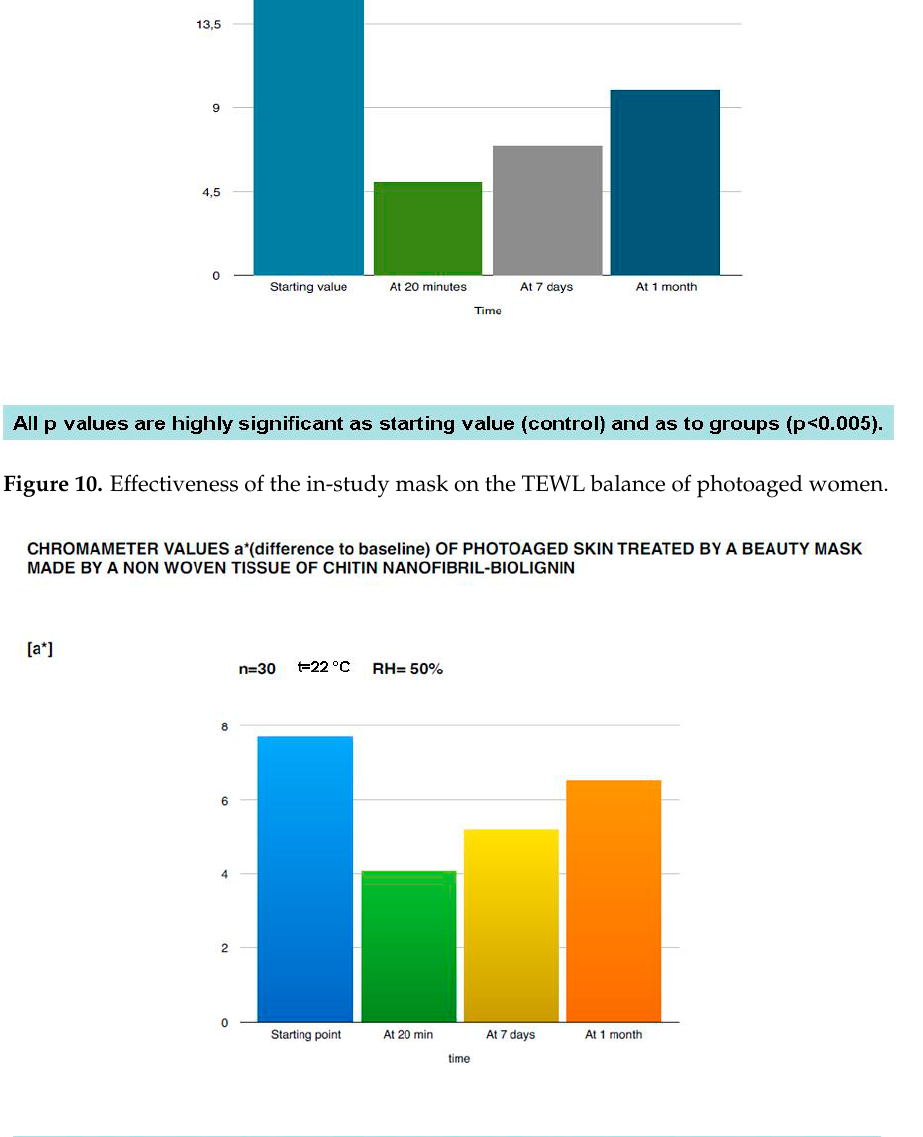
Figure 11. Anti-aging effectiveness of the mask on the black spots of photoaged women.